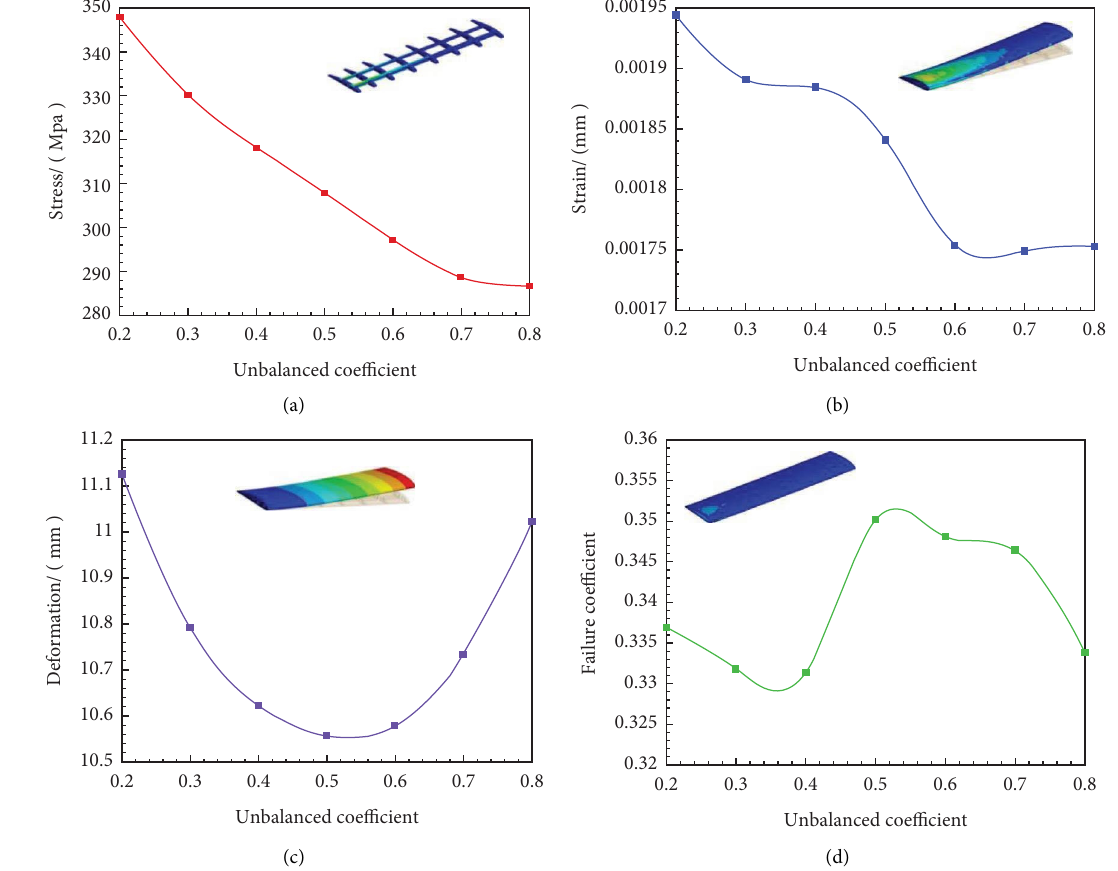
Figure 7: Structural stress, strain, displacement, and failure at diferent unbalanced coefcients. (a) Stress curve. (b) Strain curve. (c) Displacement curve. (d) Failure coefcient change curve.